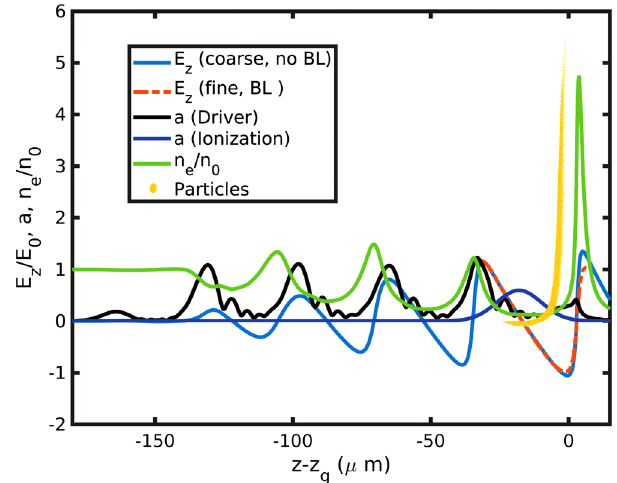
FIG. 5. Charging phase. On-axis lineout of the longitudinal electric field E without beam-loading (blue), of E in the refined z z grid and including beam-loading (dashed orange), of the plasma density (green), of the driving train amplitude (black) and of the third-harmonics ionizing pulse amplitude (purple). The longi- tudinal phase-space plot of the newborn electrons (yellow dots) is also